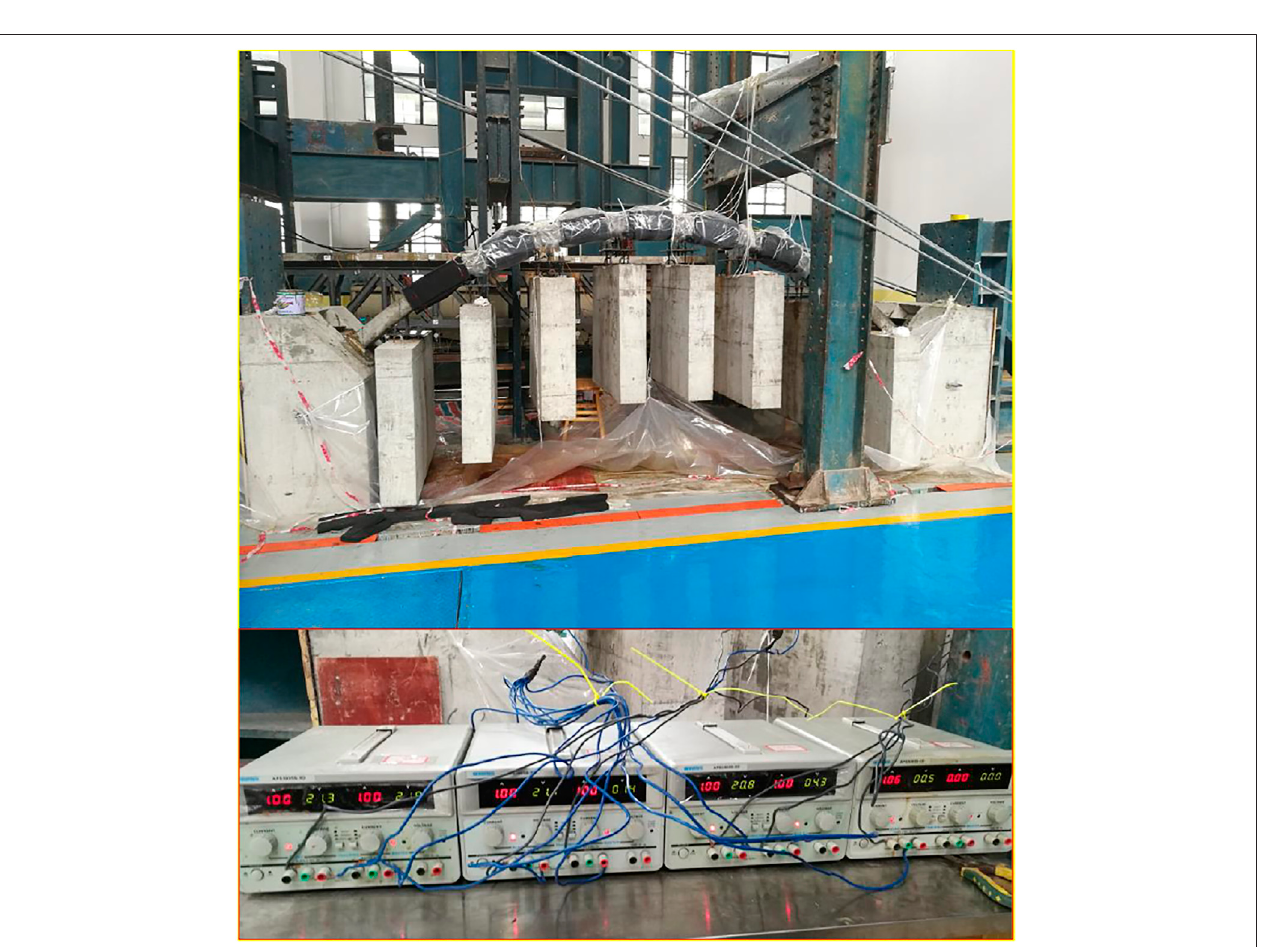
FIGURE 5 | Actual corrosion process of the arch model.